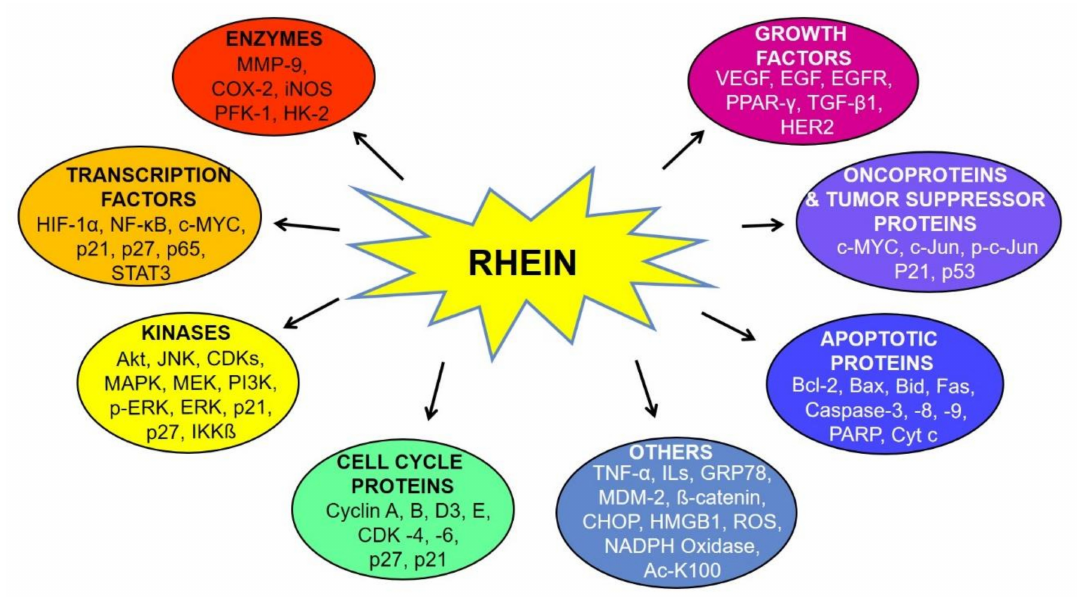
Figure 3. Molecular targets of rhein. Abbreviations: Ac-K100: acetylated lysine; Bax: Bcl-2-associated